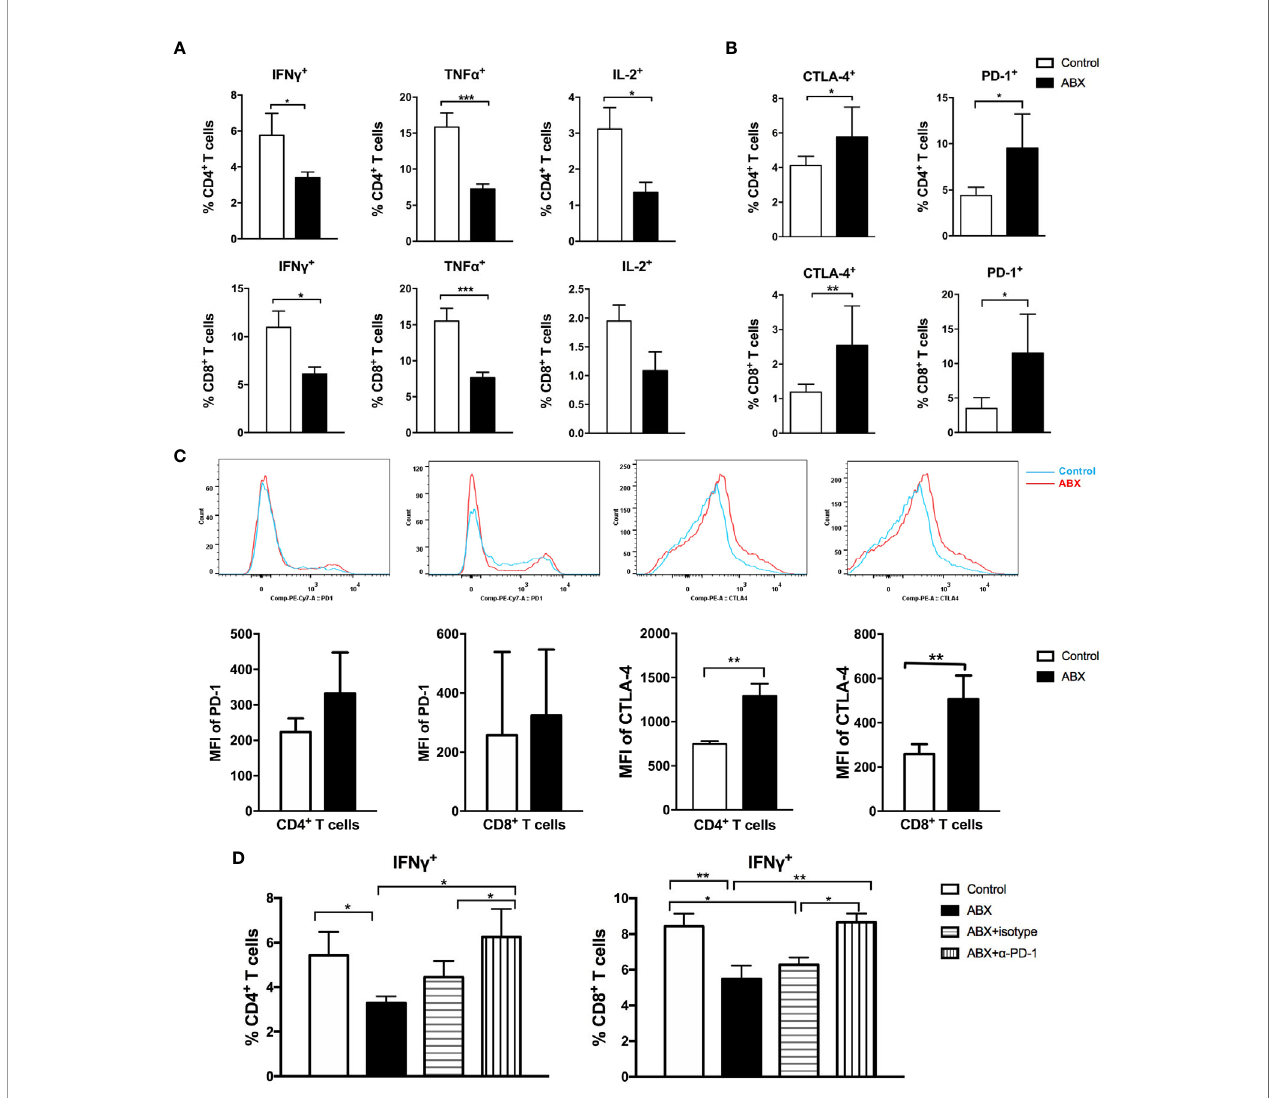
FIGURE 5 | T cell function in liver was impaired after gut microbiota depletion. Intrahepatic lymphocytes were isolated and stimulated with anti-CD3 and anti-CD28. The expression of intracellular cytokines (A) , immune check point molecules PD-1 and CTLA-4 (B) , the MFI of PD-1 and CTLA-4 (C) in lymphocytes were analyzed. (D) After blocking with a -PD-1, the expression of IFN- g in T cells were analyzed. n=10/group, *P < 0.05, **P < 0.01, ***P <